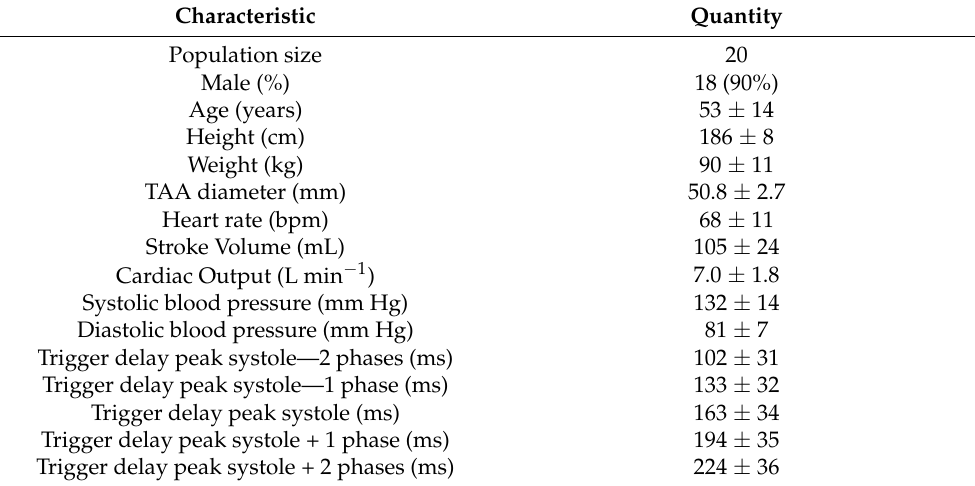
Table 1. Population characteristics.